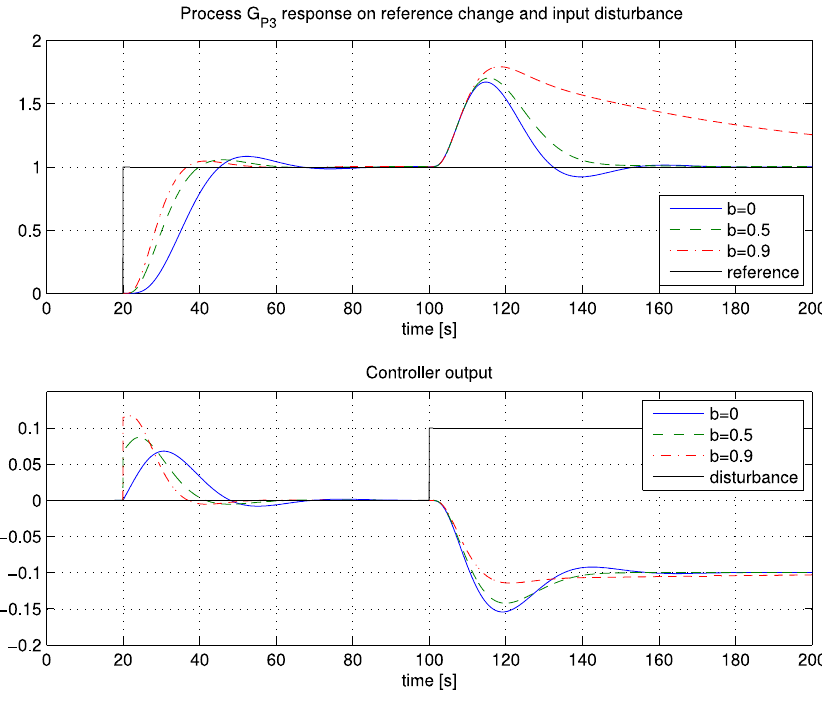
Figure 10. G P 3 process closed-loop experiment.